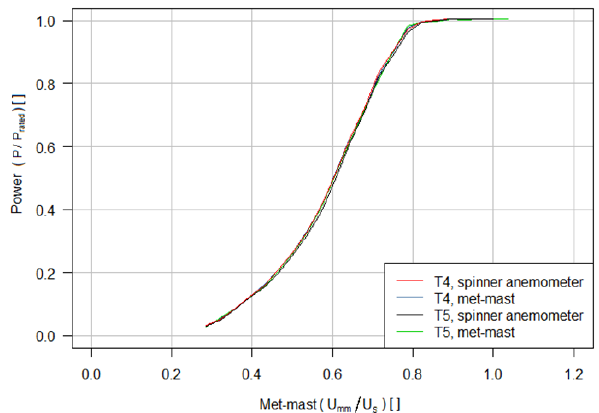
Figure 10. Power curves of wind turbines 4 and 5, measured with met mast and with spinner